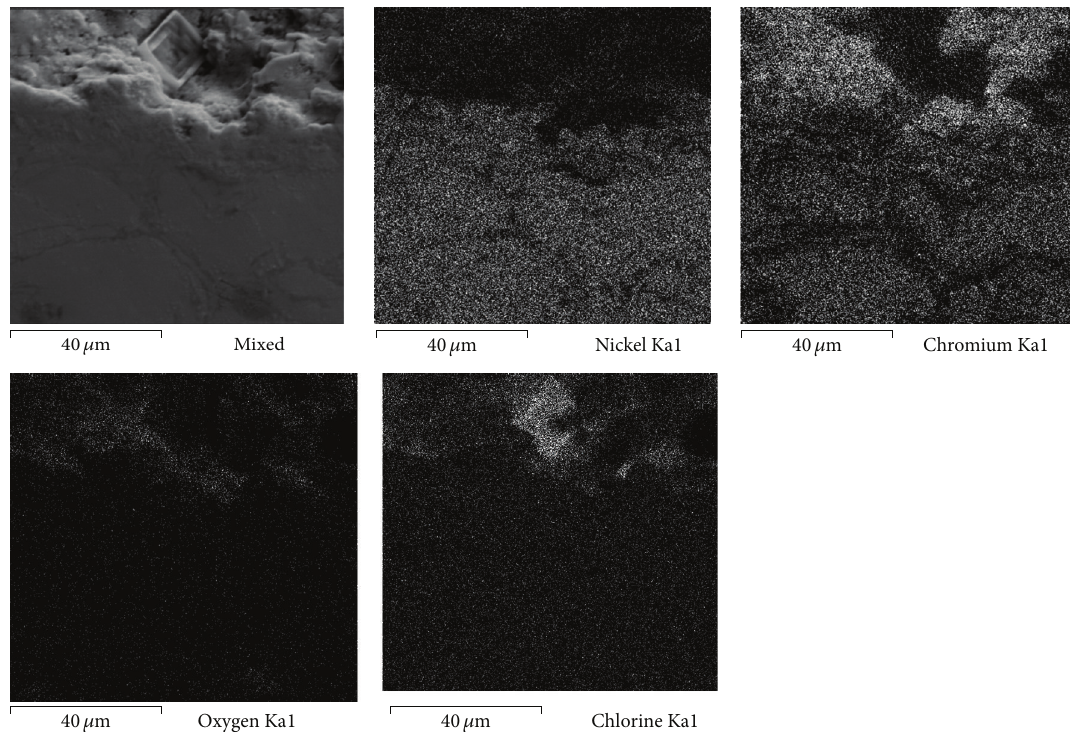
Figure 8: Cross-sectional aspect of the Ni20Cr as-deposited coating and elements distribution after corrosion test at 400 ∘ C.